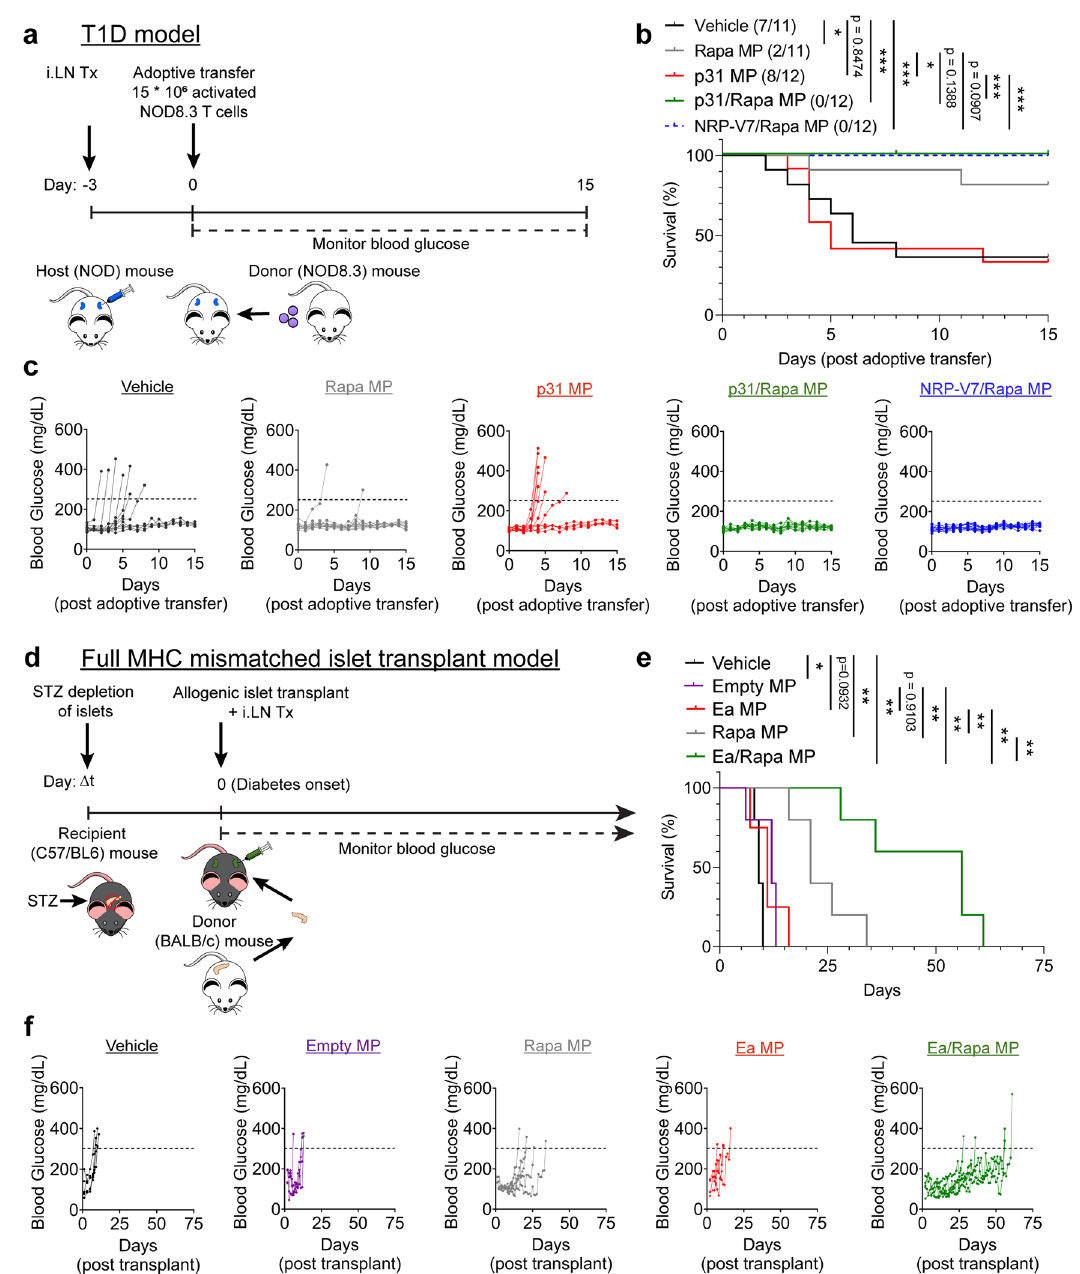
Fig. 3 | iLN injection of tolerogenic MPs promotes tolerance in T1D and sup- pression of graft rejection in allogenic islet transplantation. a Schematic representation of prophylactic iLN treatment in the NOD8.3 model of T1D. b Survivalcurvewithnumberofmicewhichdevelopeddiseaseoutofthetotalmice per group indicated in the parenthesis in the legend. c Individual blood glucose traces for miceineachgroup from b . d Schematicrepresentationof iLN treatment